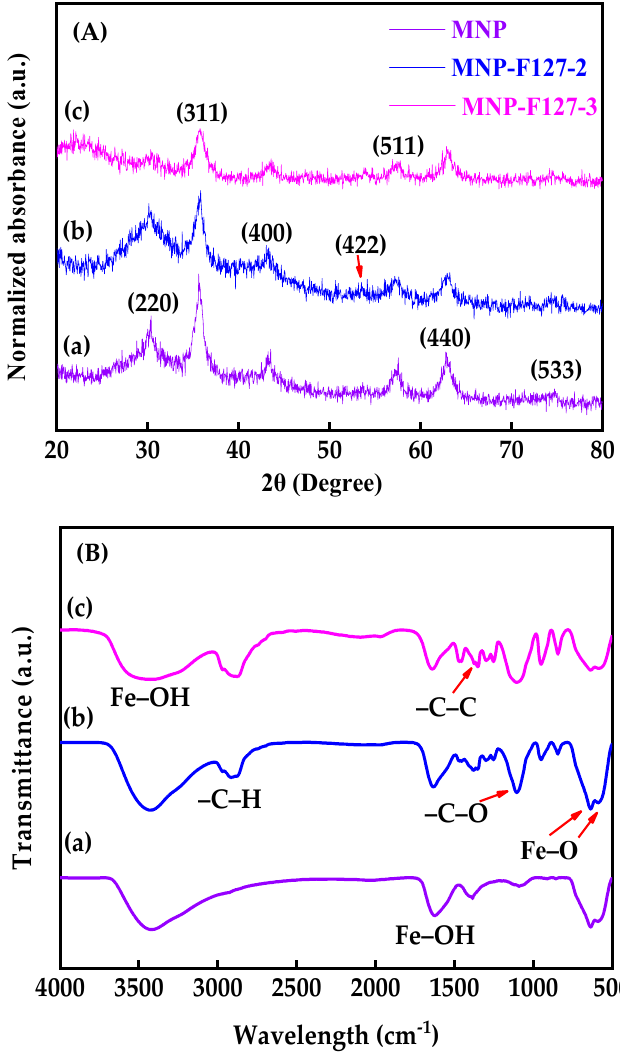
Figure 2. ( A ) XRD patterns and ( B ) FTIR absorbance spectra of ( a ) MNP, ( b ) MNP-F127-2, and ( c ) MNP-F127-3 nanocomposites.